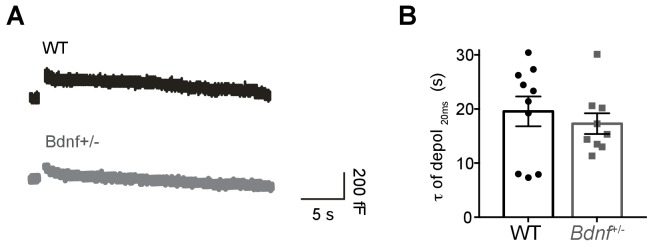
Reduction of endogenenous BDNF does not affect endocytosis in the calyx of Held.(A) Representative membrane capacitance (Cm) induced by 20 ms depolarization from P9-13 calyx terminals in WT (black) and Bdnf+/- (gray) mice. The capacitance decay (τ of depol20ms) was measured from the exponential fit and indicates endocytosis rate. τ of depol20ms was measured within 30 s after 20 ms depolarization from −80 to 0 mV. (B) Summary of endocytosis rate, which is similar between WT (black; 19.56 ± 2.7 s; n = 10) and Bdnf+/- mice (gray; 17.29 ± 1.9 s; n = 9; p=0.51). Data are shown as the mean ± s.e.m. Unpaired t-test.